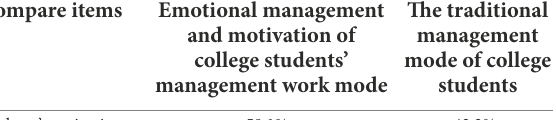
TABLE 4 Comparison of the average data of the two modes of college student management work. Compare